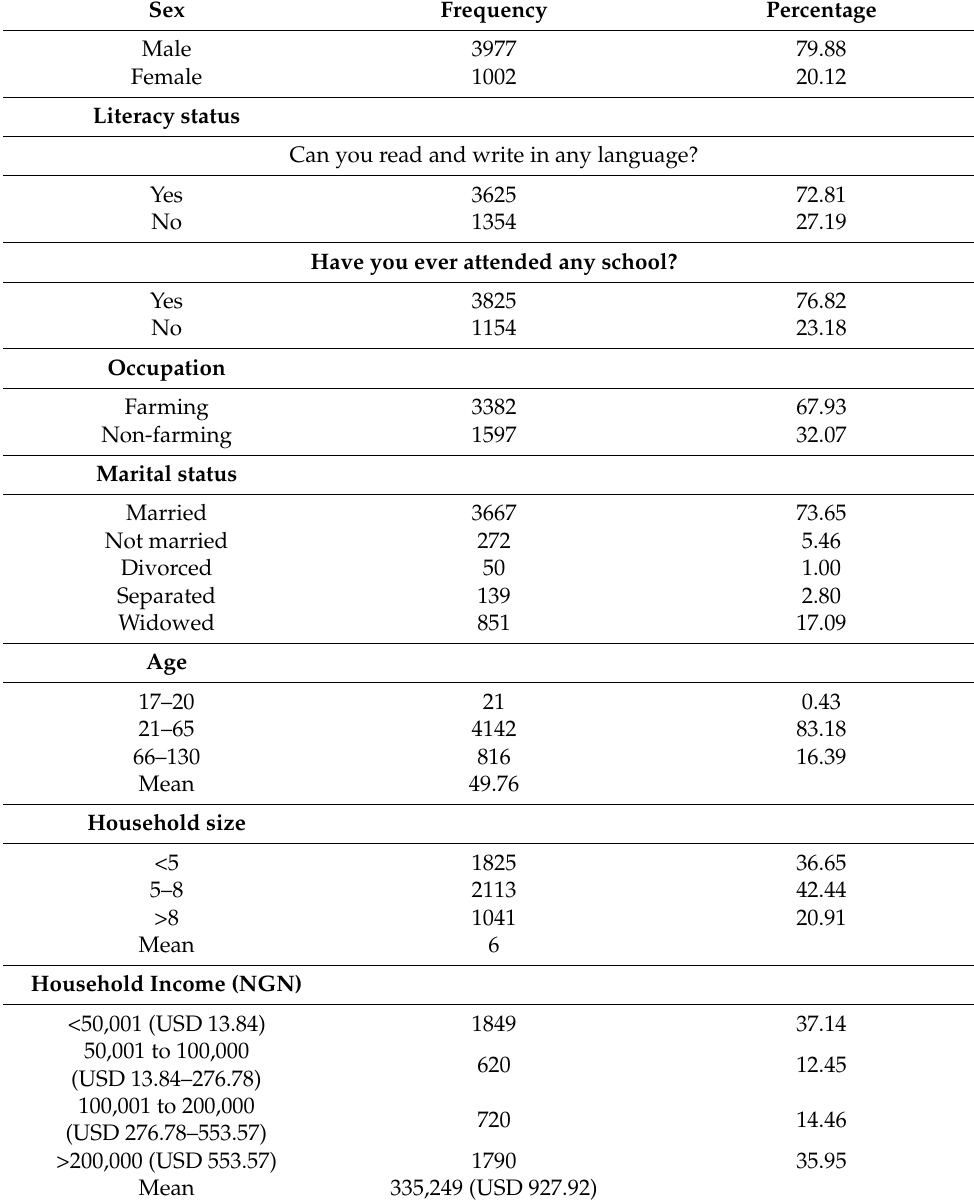
Table 2. Socioeconomic characteristics of households in